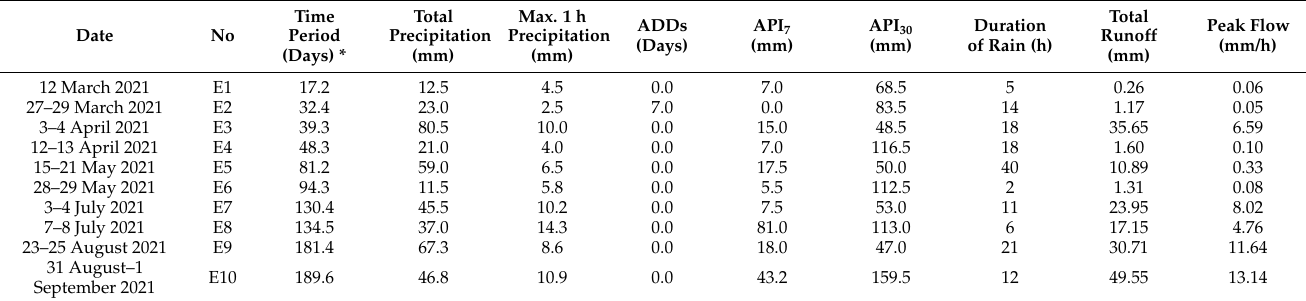
Table 1. Summary of rainfall events and runoff volumes from which water samples were collected.